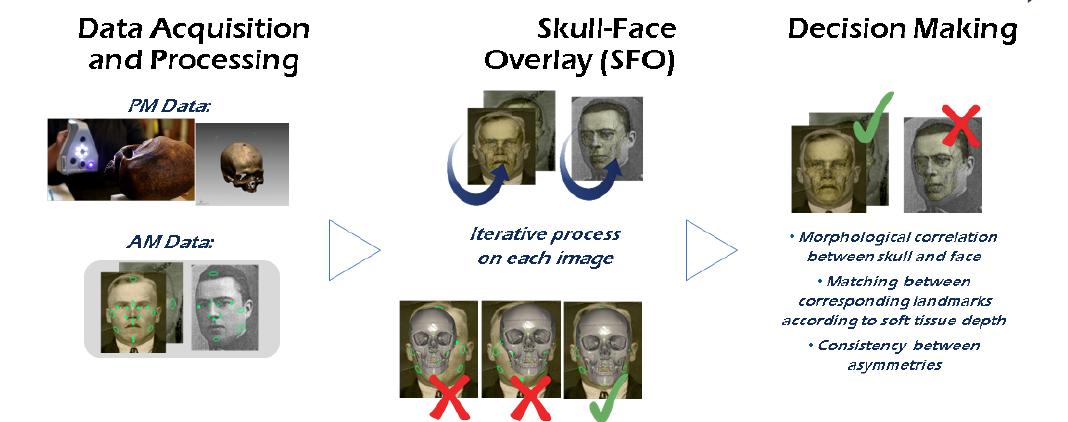
Figure 4. General Craniofacial Superimposition (CFS)-based ID